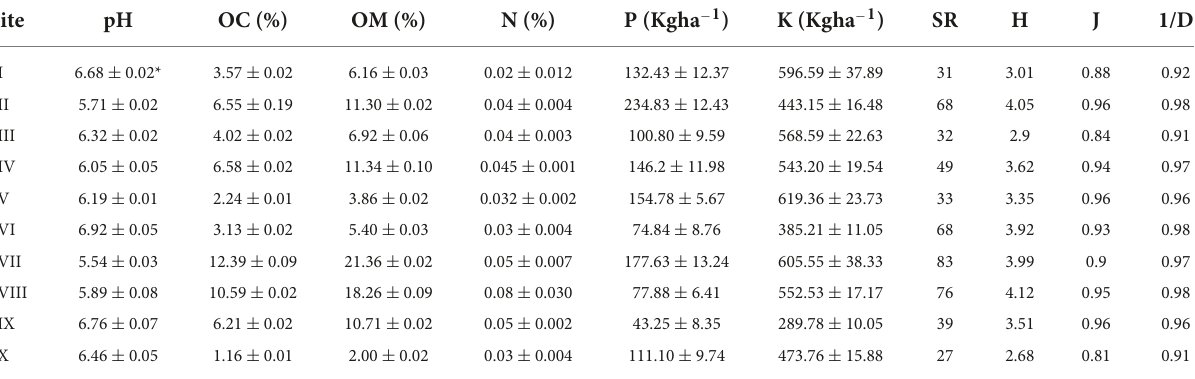
Table 2 Soil chemical properties and floral diversity parameters of selected study sites in Kashmir Himalaya (OC–organic carbon, OM–organic matter, N–Nitrogen, P–phosphorus, K–potassium; SR–species richness, H–Shanon-weiner index, J–Jaccard’s index of evenness, 1/D–Simpson’s